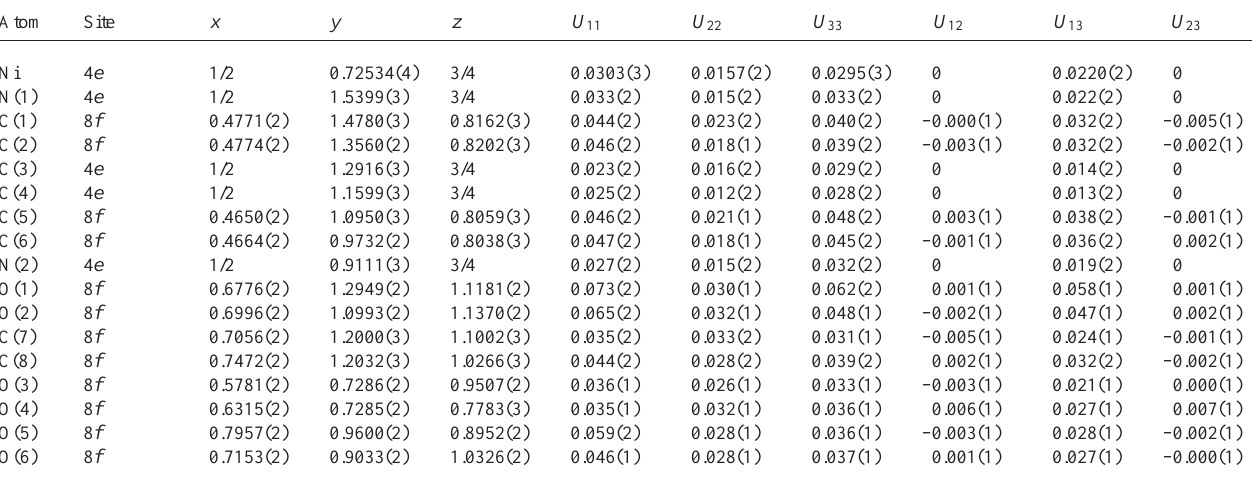
Table 3. Atomic coordinates and displacement parameters (in Å 2 )